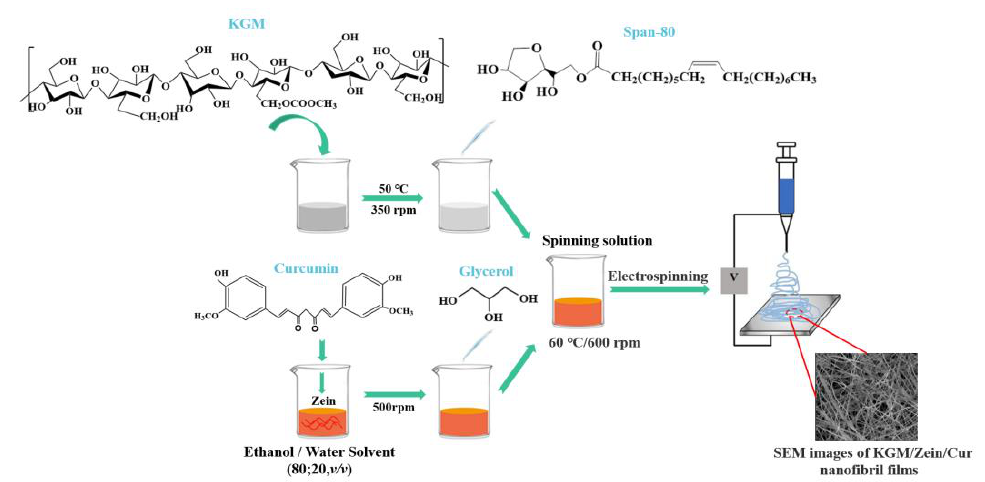
Figure 3. Schematic representation of preparing KGM/Zein/Cur nanofibril films via electrospinning (Adopted from Wang et al. and Li et al.) [88,90]. Nanofiber films were prepared via electrospinning of the solution loaded into a syringe covered with a 23-gauge stainless steel needle, at a controlled feed rate of 1 mL/h and an applied voltage. The nanofiber films were collected on a metal plate under conditions of 55 ◦ C and 50%